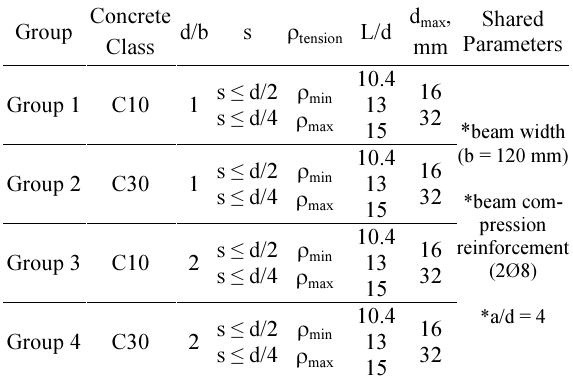
Fig. 14. Verification results for un-strengthened and strengthe- ned beams both without damage